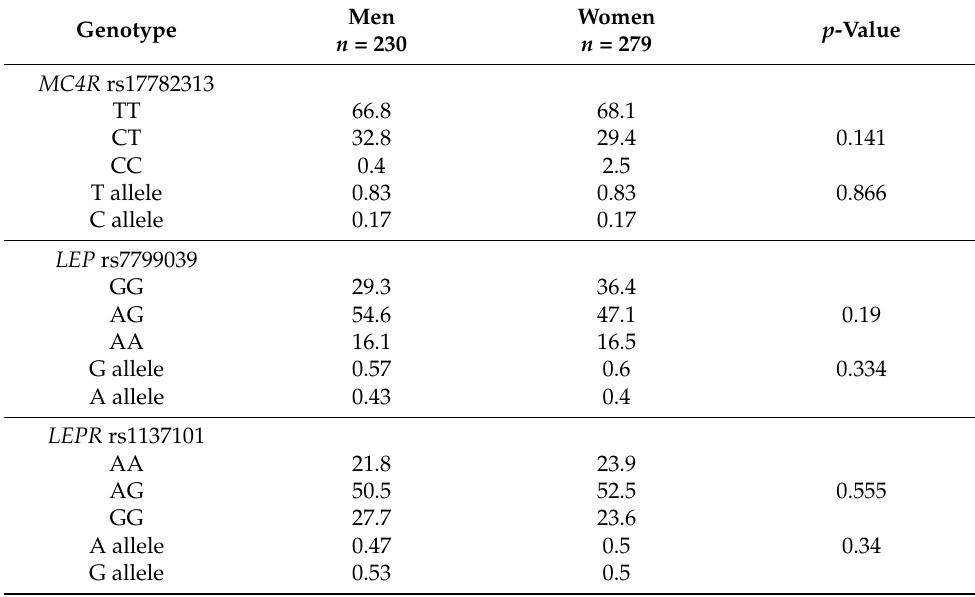
Table 2. Distribution of genotypes and allele frequencies